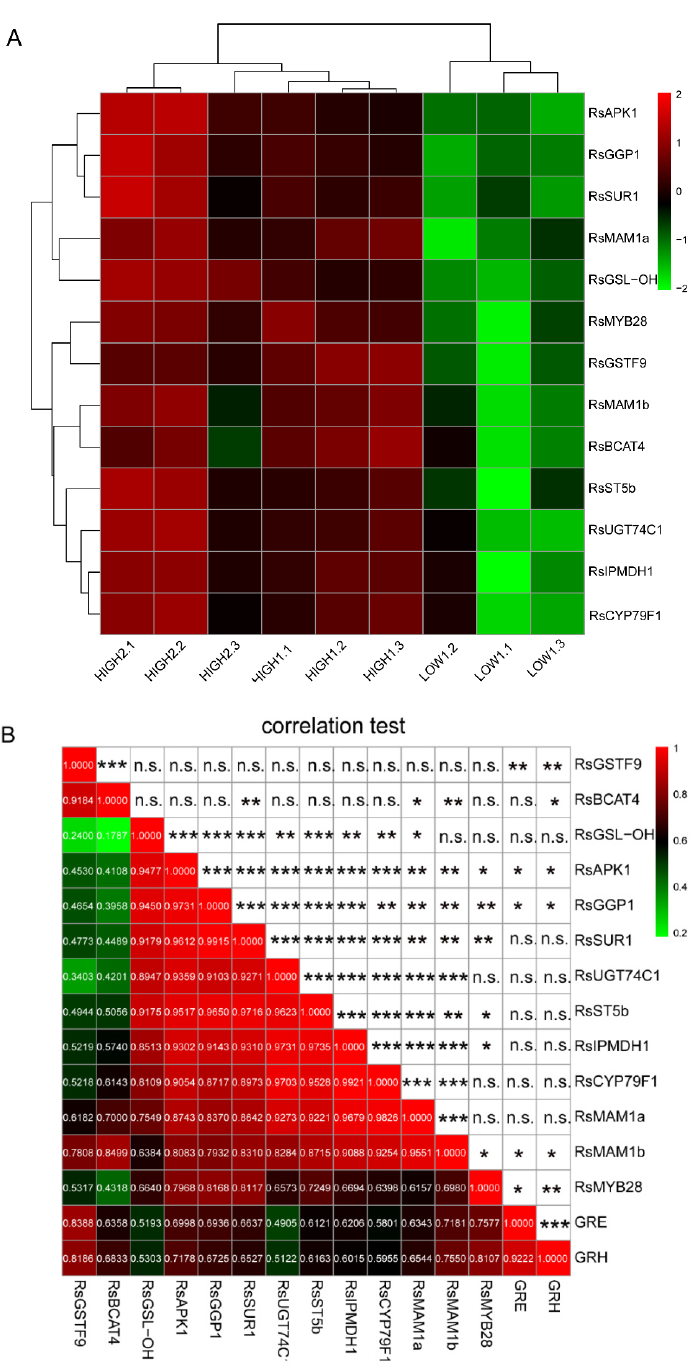
Figure 4. Differential expression of key GSLs pathway-related genes and their correlations in different radish samples. ( A ) Heatmap visualization of the relative gene expression levels in different radish taproots. The legend shows the up- and downregulation expression pattern that was maintained in each sample. ( B ) The Pearson’s coefficient (r) and correlation significance (asterisks) are elucidated in a symmetric matrix prepared using the same variables as in A, with the addition of the GRH and GRE content. The location of the variables in the heatmap are based on the results of hierarchical clustering; the negative and positive correlations are shown in green and red squares, respectively, and the r values are shown in the squares. *, **, and *** indicate significance at p ≤ 0.05, p ≤ 0.01, and p ≤ 0.001, respectively; n.s., not significant.